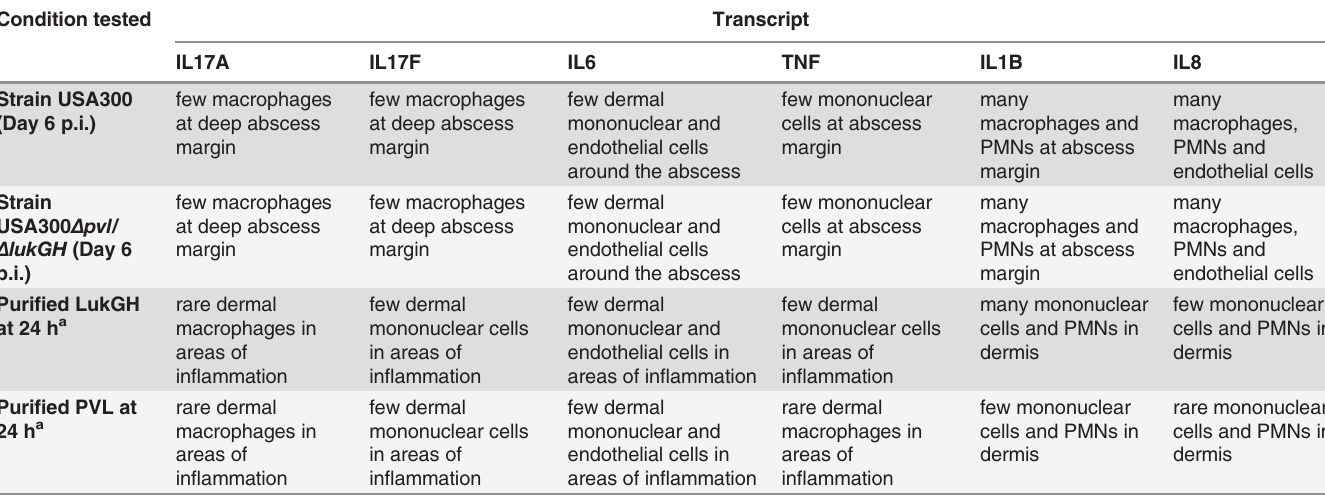
Table 2. Cytokine pro fi ling in vivo . Condition